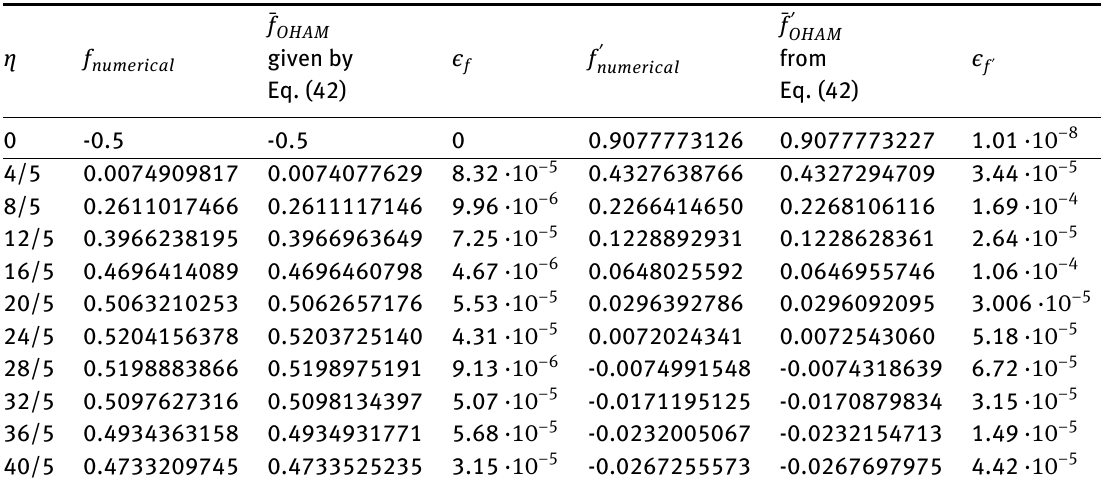
Table 2: Comparison between OHAM results ( ¯ f , ¯ f ′ ) given by Eq. (42) and numerical results, for S = −0.5 , λ = 0.1 (relative errors: ϵ f = | f numerical − ¯ f OHAM | , ϵ